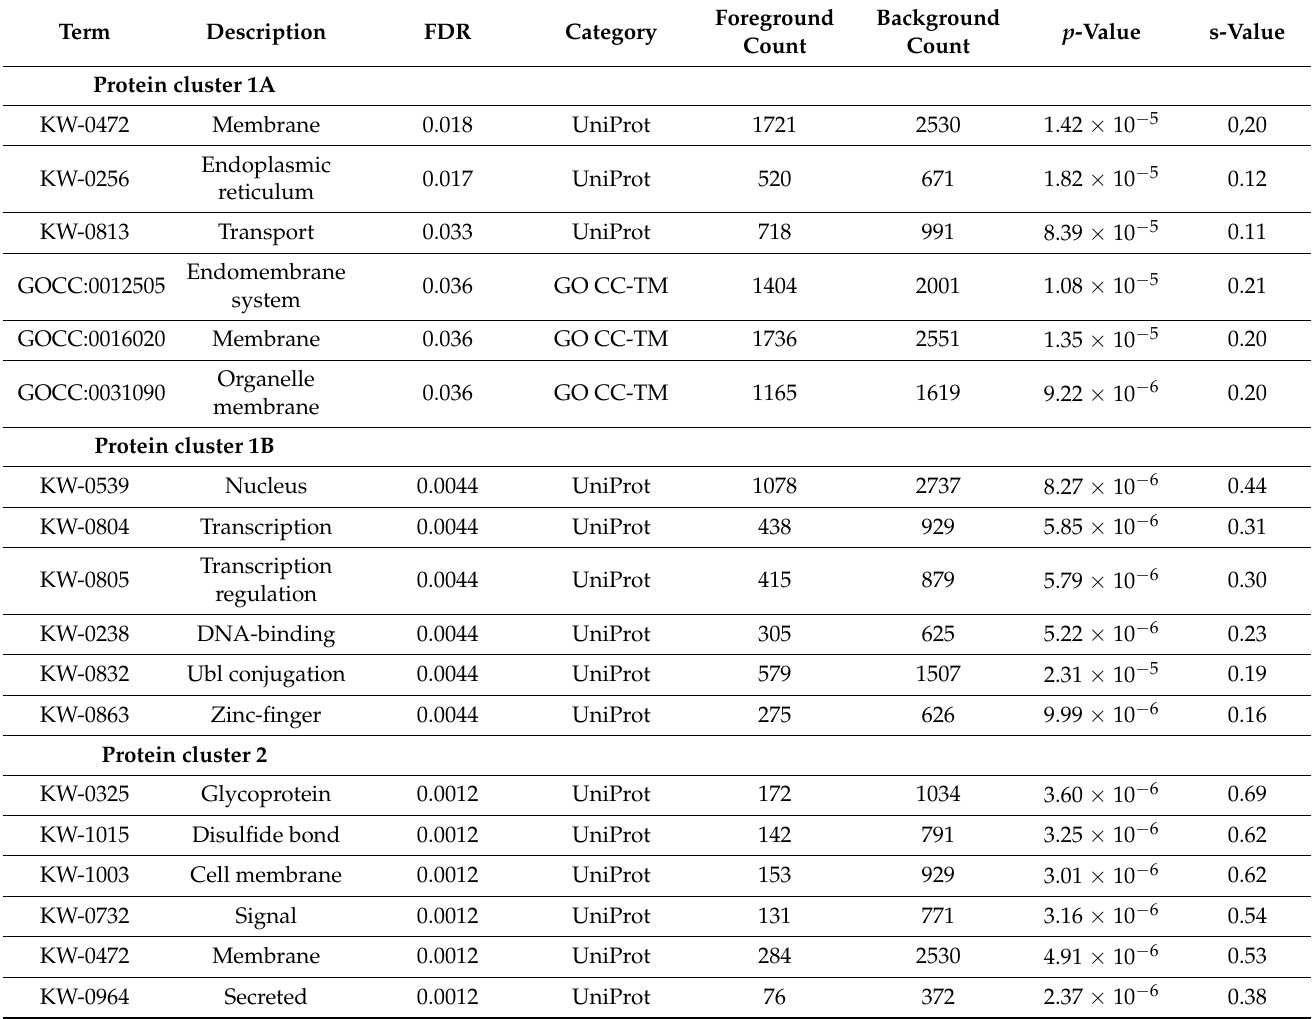
Table 5. Classification of proteins included in the three major protein subsets (clusters A1, A2, and B) identified in the unsupervised hierarchical cluster analysis based on the overall proteomic profiles for the 32 patients (Figure 3). We used a GO tool for the analysis. This table presents the six terms with the lowest false discovery rate (FDR) when analyzing GO cellular component/cellular component text mining, GO biological process, GO cell components, GO molecular function, KEGG pathways, Reactoma pathways, and UniProt keywords for each of the three protein subsets. The table presents the description of each term together with foreground and background counts, as well as p - and s-values. S-value is a combination of (minus log) p value and effect size (i.e., positive associations in the foreground divided by all associations); a positive value indicates overrepresentation of a given term, and a negative value indicates underrepresentation of a given term. Foreground counts indicate the number of positive associations in a given cluster for a given term (i.e., the number of proteins associated with the given term) and background counts indicate the number of positive associations in the